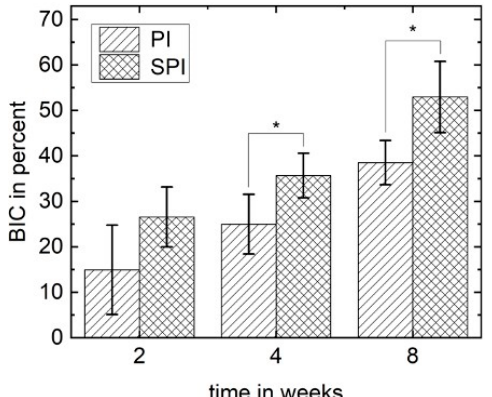
Figure 5. Bone to implant contact (BIC) of the PI and SPI group with standard deviation. The mean BIC of both groups increases as a function of time. After 4 and 8 weeks, the BIC is significantly higher for SPI (* p <